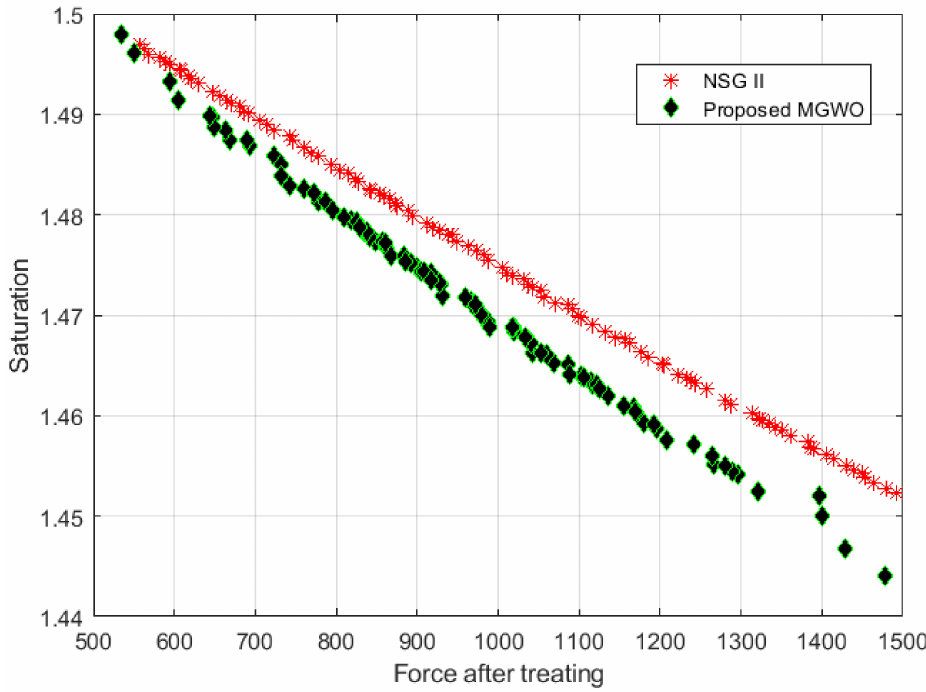
Figure 12. Pareto set via MGWO and NSGA